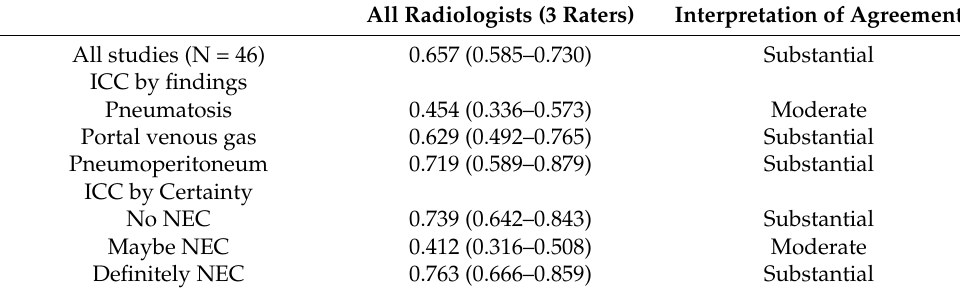
Table 6. Radiologist Intraclass Correlation (ICC) by Fleiss multi-rater Kappa. All Radiologists (3 Raters) Interpretation of